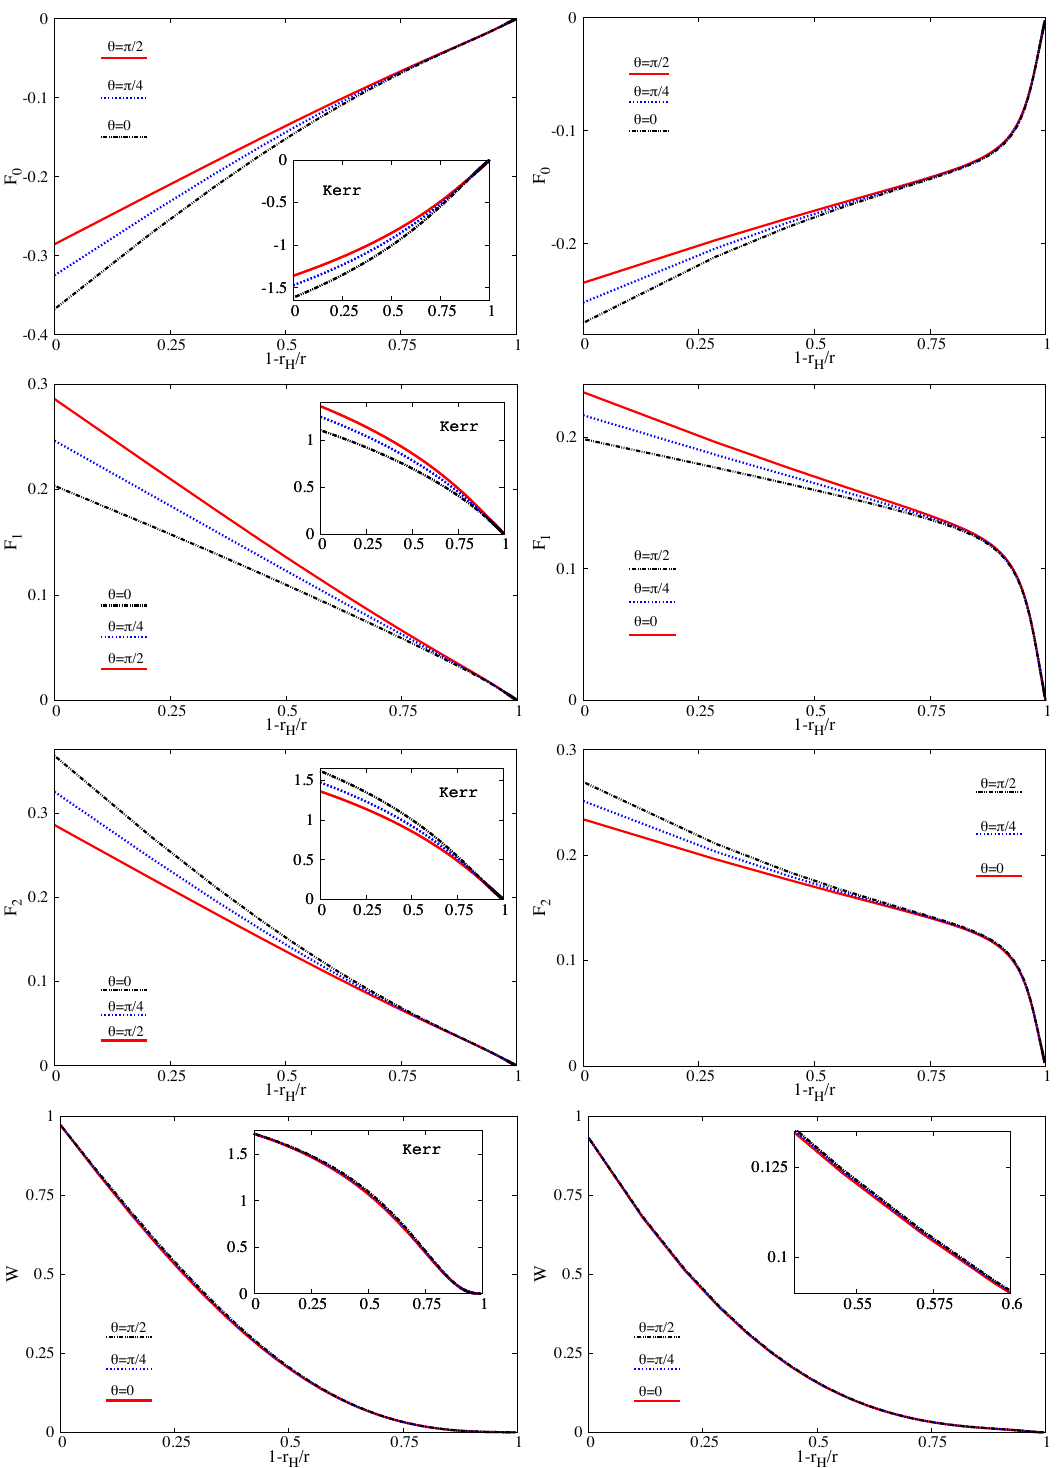
Figure 9 . Metric functions of HBH 1 (left panel) and HBH 2 (right panel).